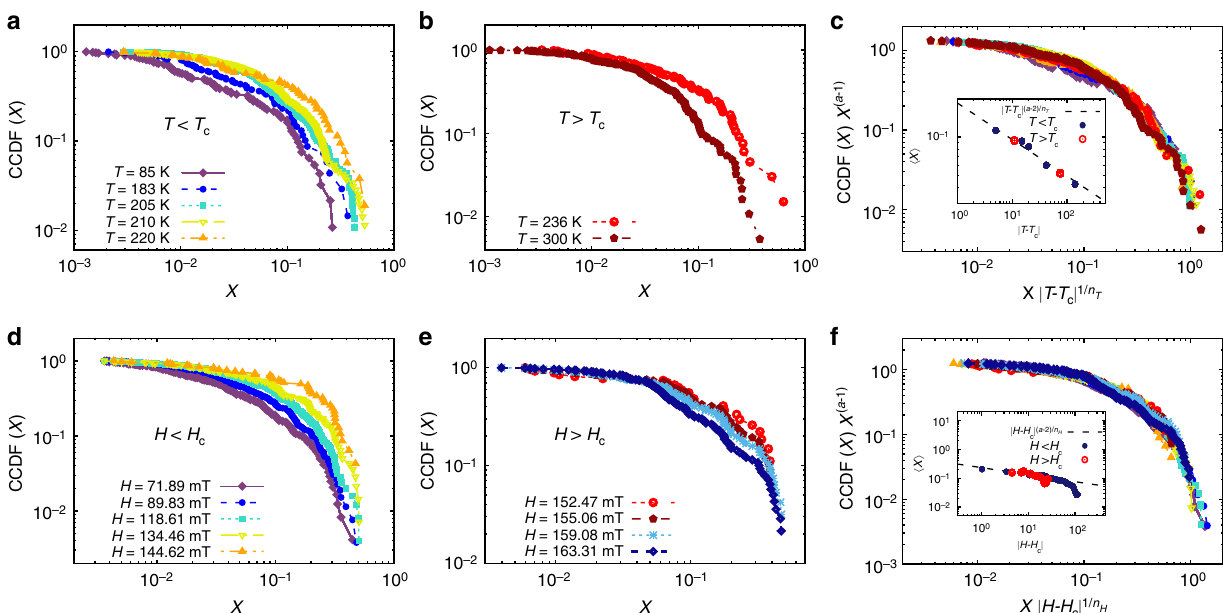
Fig. 5 Scaling collapse for stripe phase: Stripe phase, with critical values T Cstripe = 225 K and H Cstripe = 148 mT. Complementary cumulative distribution function of domain cascades at ( a , b ) H = H Cstripe and ( d , e ) T = T Cstripe . a, d Distribution corresponding to values below the critical point. b and e Distributions corresponding to values above the critical point. Scaling collapse at H = H Cstripe ( c ) with critical exponents a H stripe = 1.1 ± 0.3, n H stripe = 3.73 ± 1.0 and T = T a T = 1.1 ± 0.2, n T = 3.4 ± 0.6. Inset : The average size of the jumps as a function Cstripe ( f ) with critical exponent values of stripe stripe of the distance to the critical point, both below (blue circles) and above (red open circles) the critical transition. The dashed line represents the fi t to 〈 X 〉 ( μ ) ∼ | μ − μ ( a − 2)/ n , with μ = T or μ = H C |